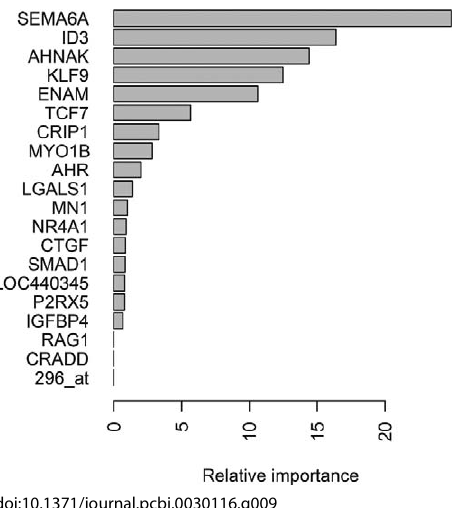
Figure 9. Display of Relative Variable Importance as Computed in a Gradient Boosting Machine